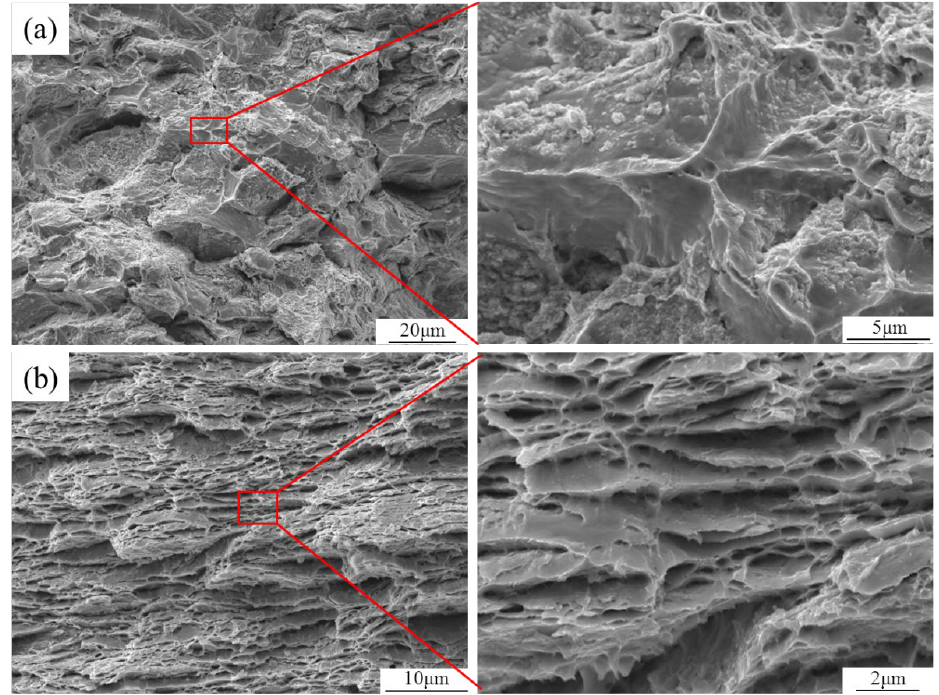
Figure 8. Tensile fracture of GNPs/Cu–Cr–Mg Composites. ( a ) Cu–Cr–Mg matrix material; ( b ) GNPs/Cu–Cr–Mg composites.